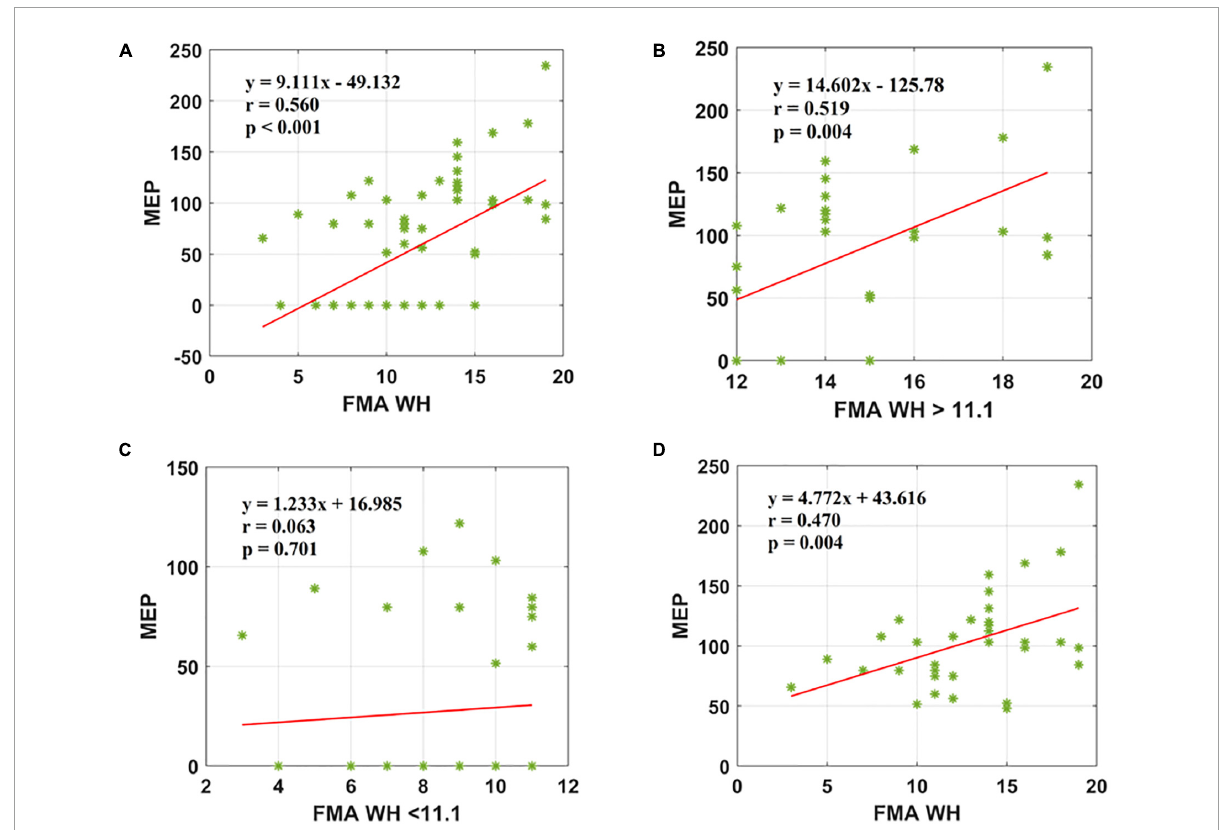
FIGURE3 Scatter plot showing the relationship between the (A) FMA W/H scores and the MEP amplitude values for all the patients, (B) FMA W/H scores > 11.1 and the MEP amplitude values obtained, (C) FMA W/H scores < 11.1 and the MEP amplitude values, (D) FMA W/H scores and the MEP amplitude values for all patients in MEP (+) group. *Represents the data of each